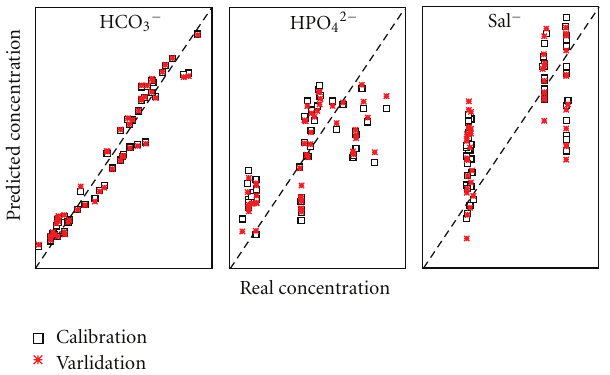
Figure 7: The results of PLS model calibration and validation in multicomponent solutions mimicking plasma for bicarbonate, hydrophosphate, and salicylate ion content